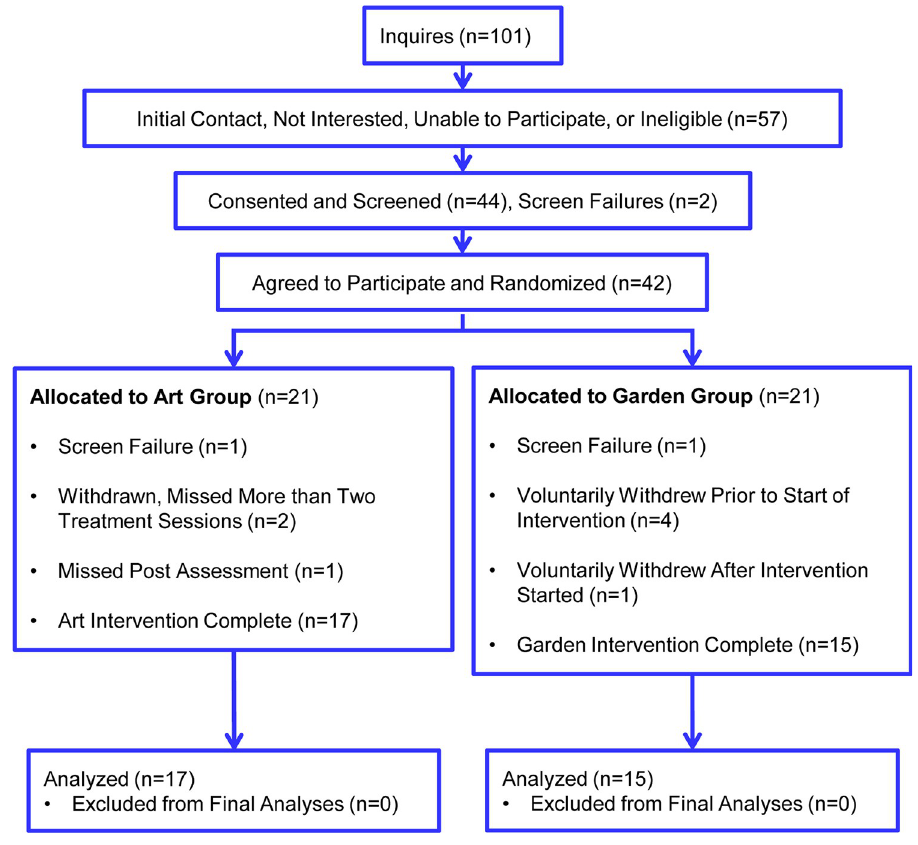
Fig 1. CONSORT (Consolidated Standards of Reporting Trials) recruitment, consenting, enrollment, screening and intervention completion diagram for the gardening and art randomized controlled trial.